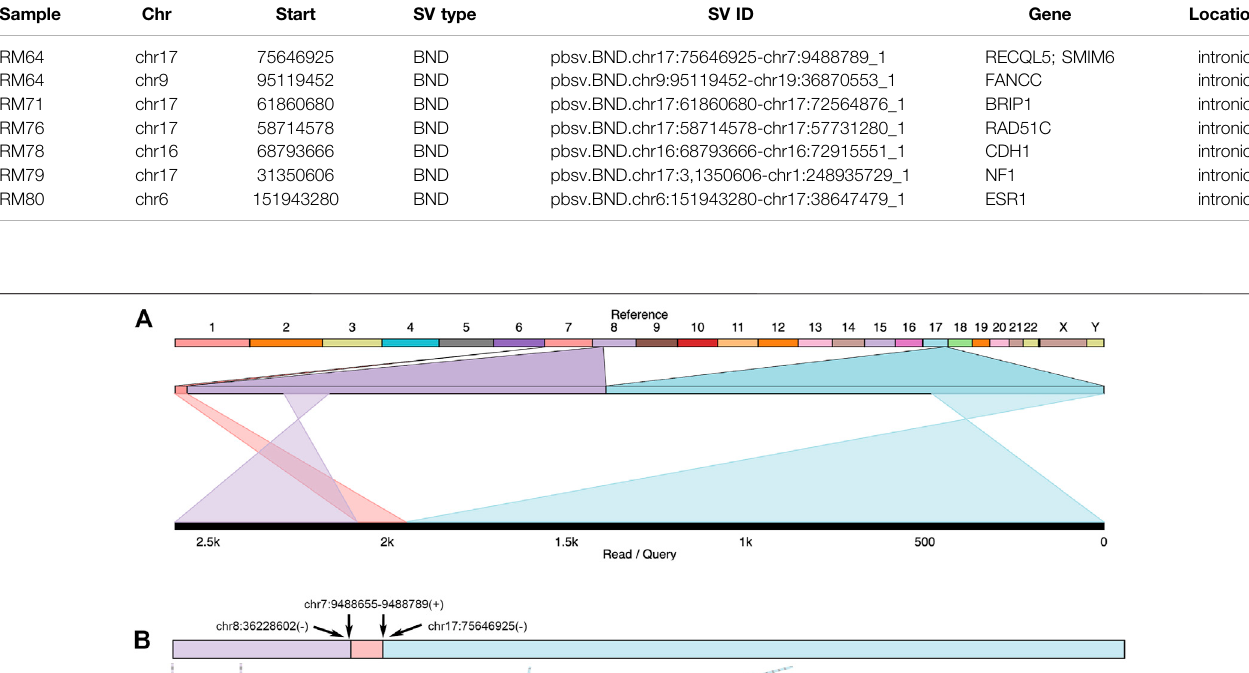
Frontiers in Cell and Developmental Biology |